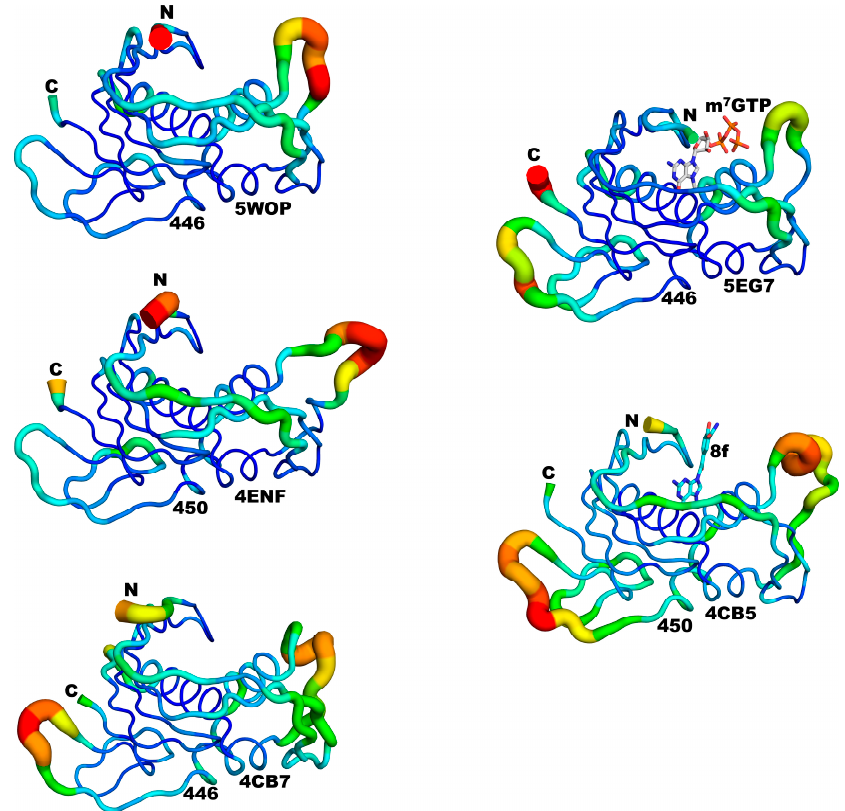
Figure 6. B-putty drawings [26] of 5WOP Chain A [13], 5EG7 [10], 4ENF [11], 4CB5, and 4CB7 Chain A [12]. The diameter of the tubes is proportional to the B-factor. The darkest shade of red corresponds to a higher B-factor, whereas the darkest shade of blue corresponds to a lower B-factor [13,23]. Crystals 2018 , 8 , x FOR PEER REVIEW